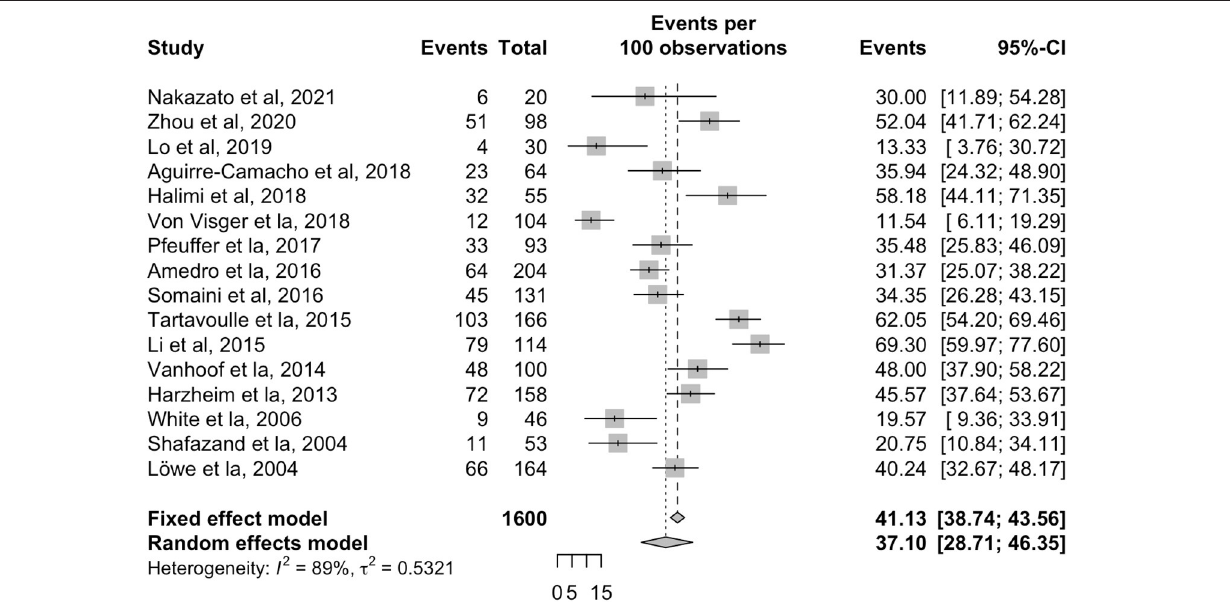
Frontiers in Medicine |